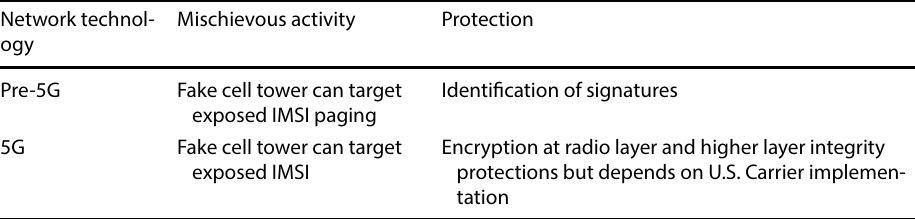
Table 8 Air interference control